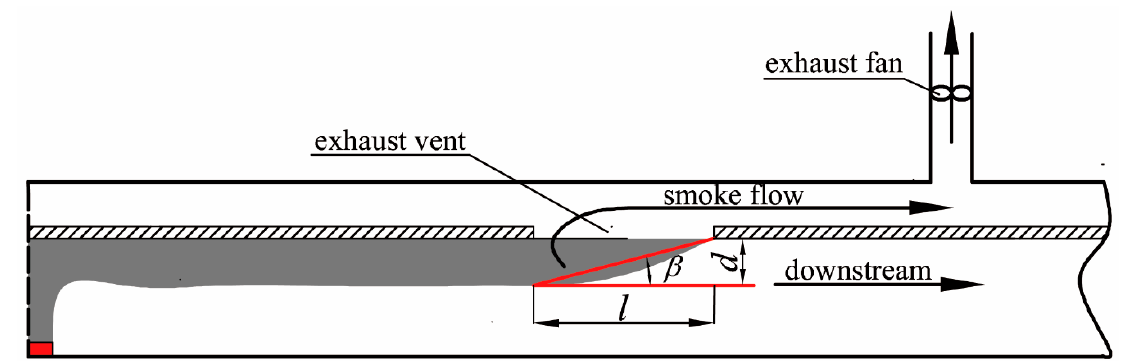
Figure 12. Schematic diagram of inclined angle β .